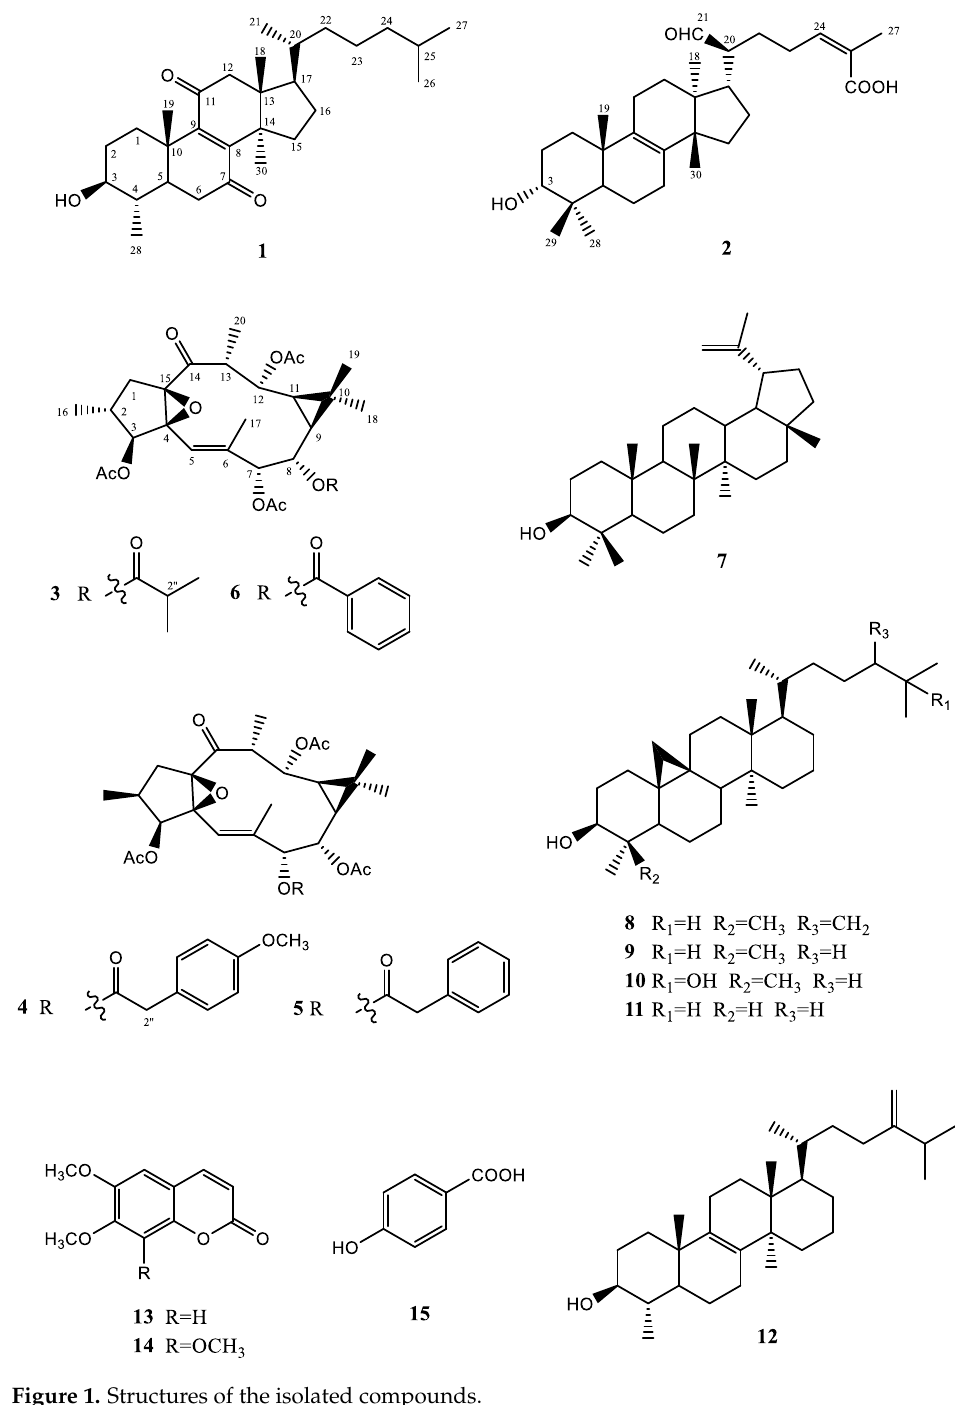
Figure 1. Structures of the isolated compounds. Compound 1 was isolated as a white amorphous powder. Its HRESIMS displayed a protonated molecule [M + H] + at m / z 443.3527 (Figure S1, Supplementary Materails), cor- responding to molecular formula C 29 H 46 O 3 . The 1 H and 13 C NMR spectra showed signals in the range of δ H 0.80 – 3.20 (including signals for 7 CH 3 groups) and signals for a total of 29 carbon atoms, respectively, suggesting that 1 is a nortriterpenoid (Table 1). Moreover, the signal at δ H 3.13, observed as ddd with J 11.2, 9.7 and 5.1 Hz, was an indication for an axial proton at C-3 in 3 β -hydroxy-29-nortriterpene [29]. This was supported by the HMBC correlations of methyl protons at δ H 1.01 (d, J = 6.3 Hz, CH 3 -28) to one oxygenated sp 3 carbon at δ c 75.4 (C-3) and two other sp 3 carbons at δ c 38.2 (C-4) and 47.1 (C-5) (Figure 2).